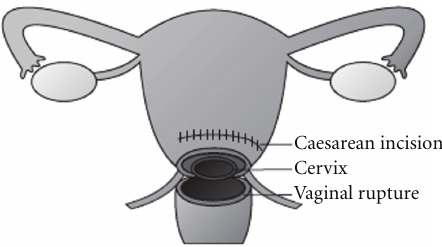
Figure 1: Anterior view of the patient’s uterus, showing the vaginal rupture and exposed